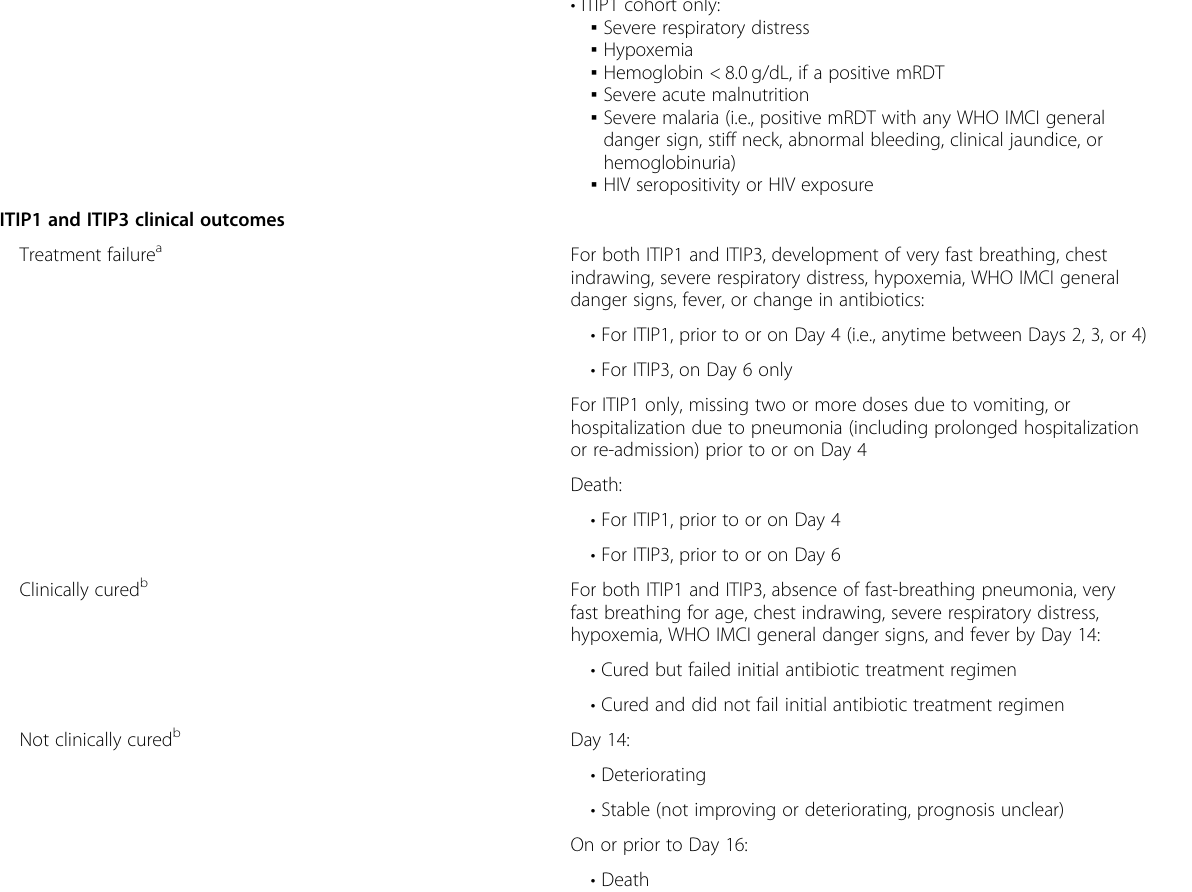
Table 1 Study definitions, eligibility criteria, and clinical outcomes (Continued)